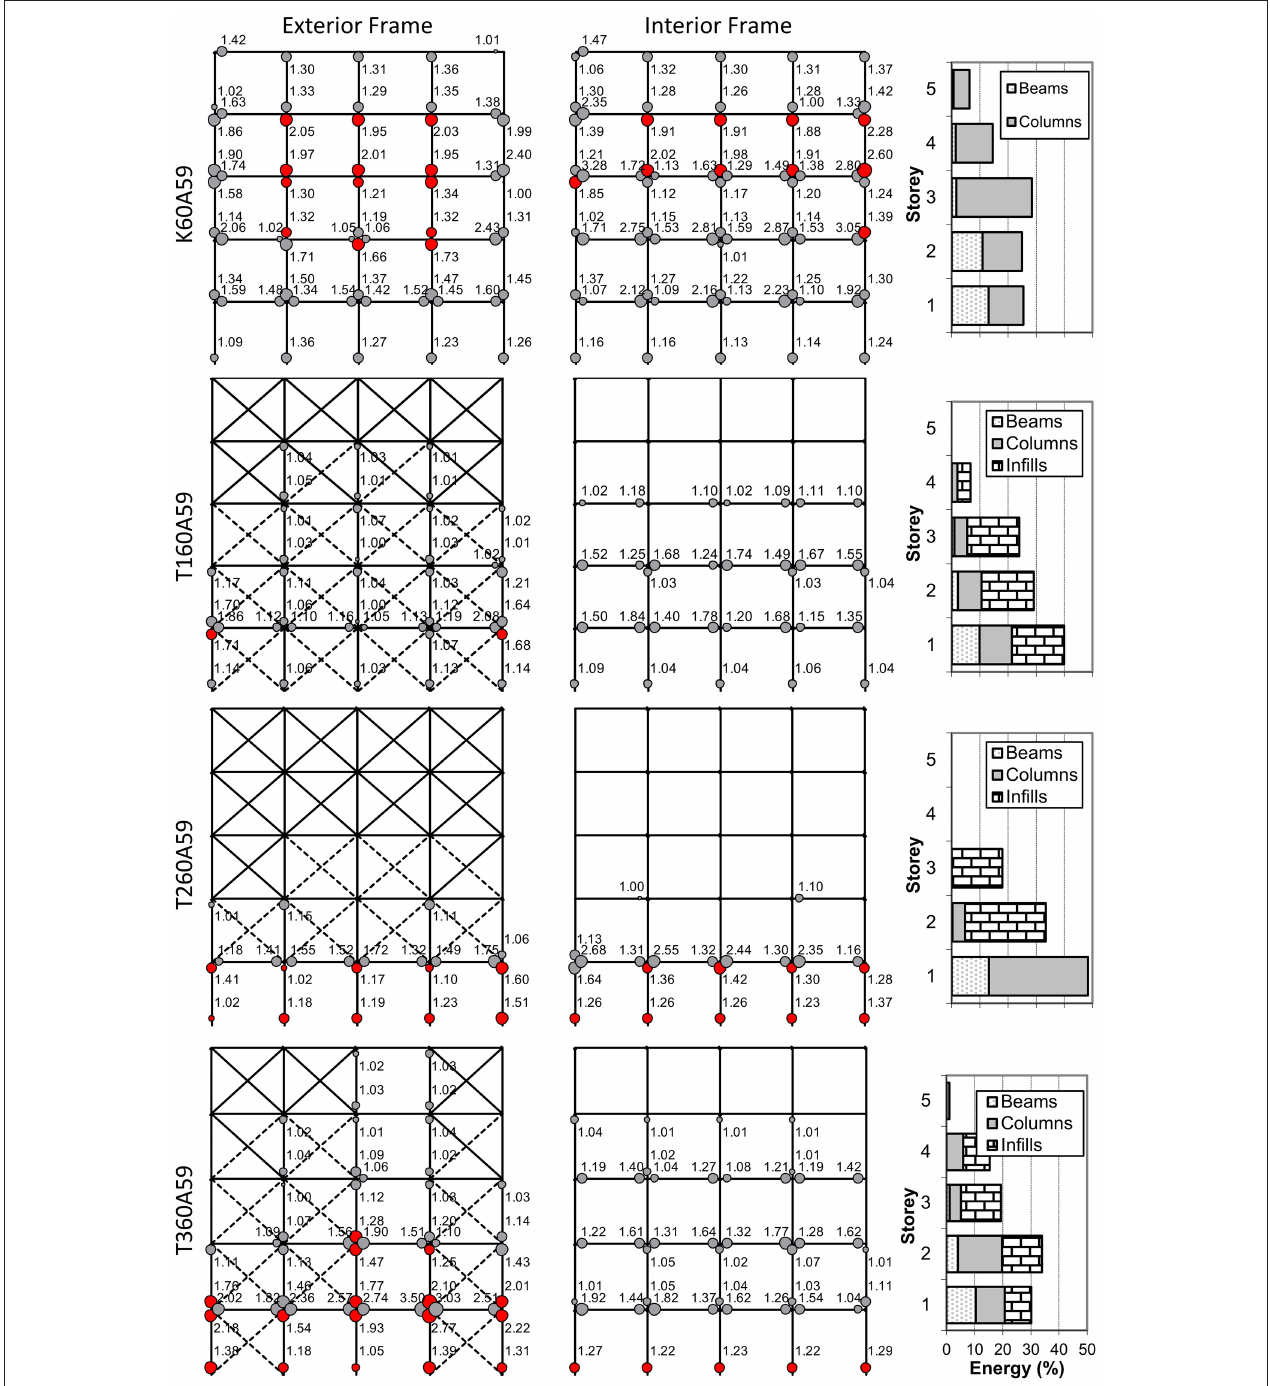
FIGURE 9 | Plastic hinge distribution, ductility rotation demands and energy absorption at the end of the analysis. KAL18601Long record (unscaled). Red plastic hinges have failed. Infills are plotted in “dashed” line if cracked. structures is reduced to half of the bare frame for T160A59 and T160AEC8, while it increases for the corresponding 70s